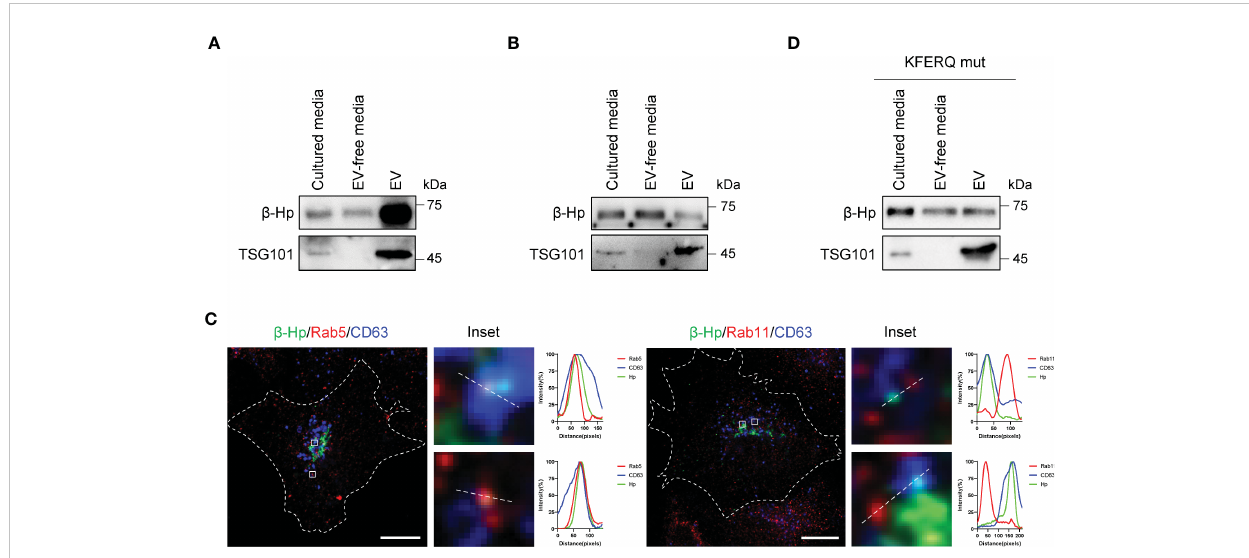
FIGURE 4 EV-Hp is secreted from CCA cells via KFERQ-like motif. (A, B) Two forms of Hp obtained from cultured media of (A) SNU-1079 and (B) HepG2 were examined; n = 5. (C) Colocalization of b -Hp with Rab5, Rab11, and CD63. Representative images are shown, Scale bar = 10 µm. n = 3. (D) Western blotting to assess the effects of KFERQ-like motif on b -Hp secretion through EV; n =